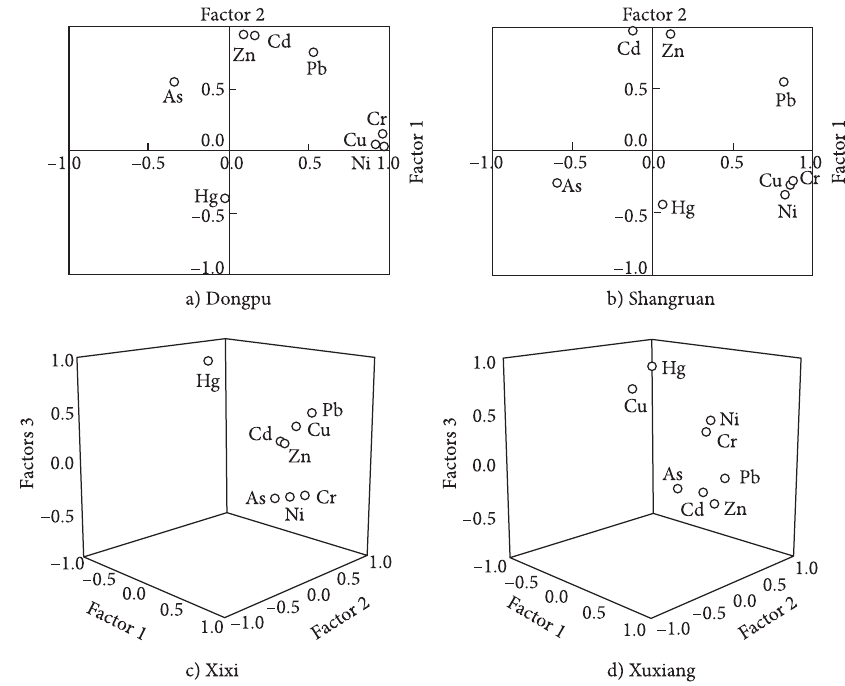
Figure 4. PCA results for the heavy metals in the soils of the four representative